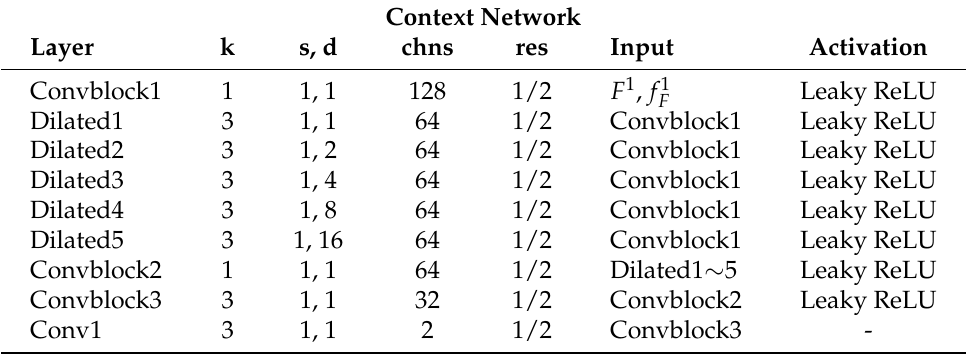
Table 2. Network architecture of the context network of our proposed